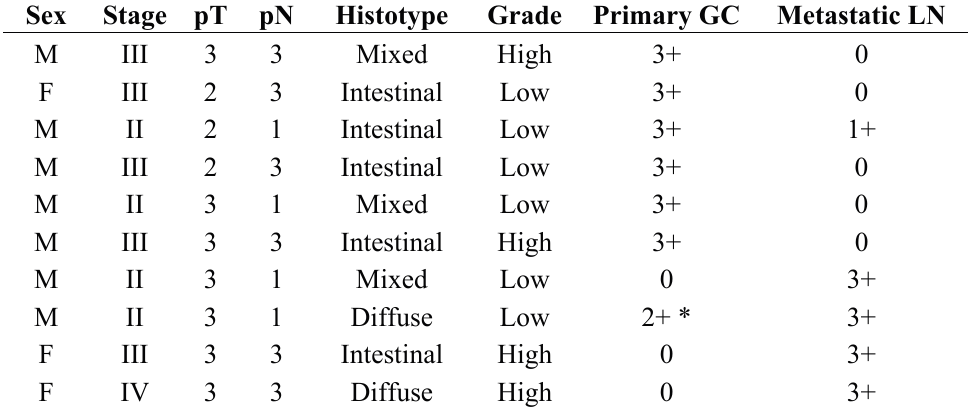
Table 3. Ten cases with changes in HER2 status between the primary GC and corresponding synchronous nodal metastases.